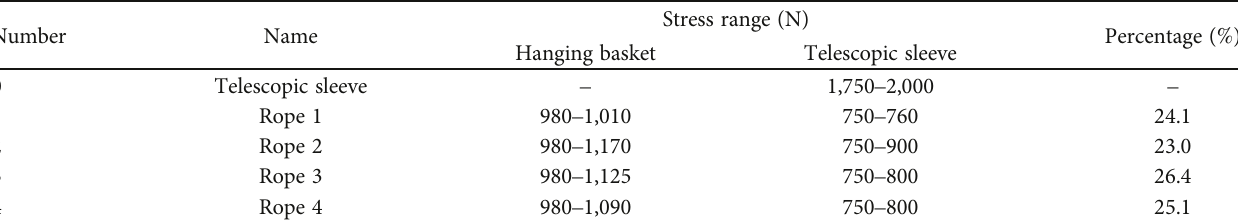
ABLE 1: Hanging basket rope force range.